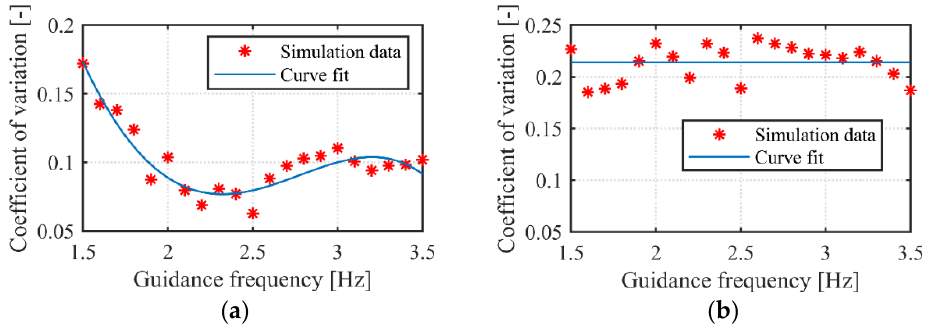
Figure 10. Modeling of the coefficient of variation of different guidance frequencies.